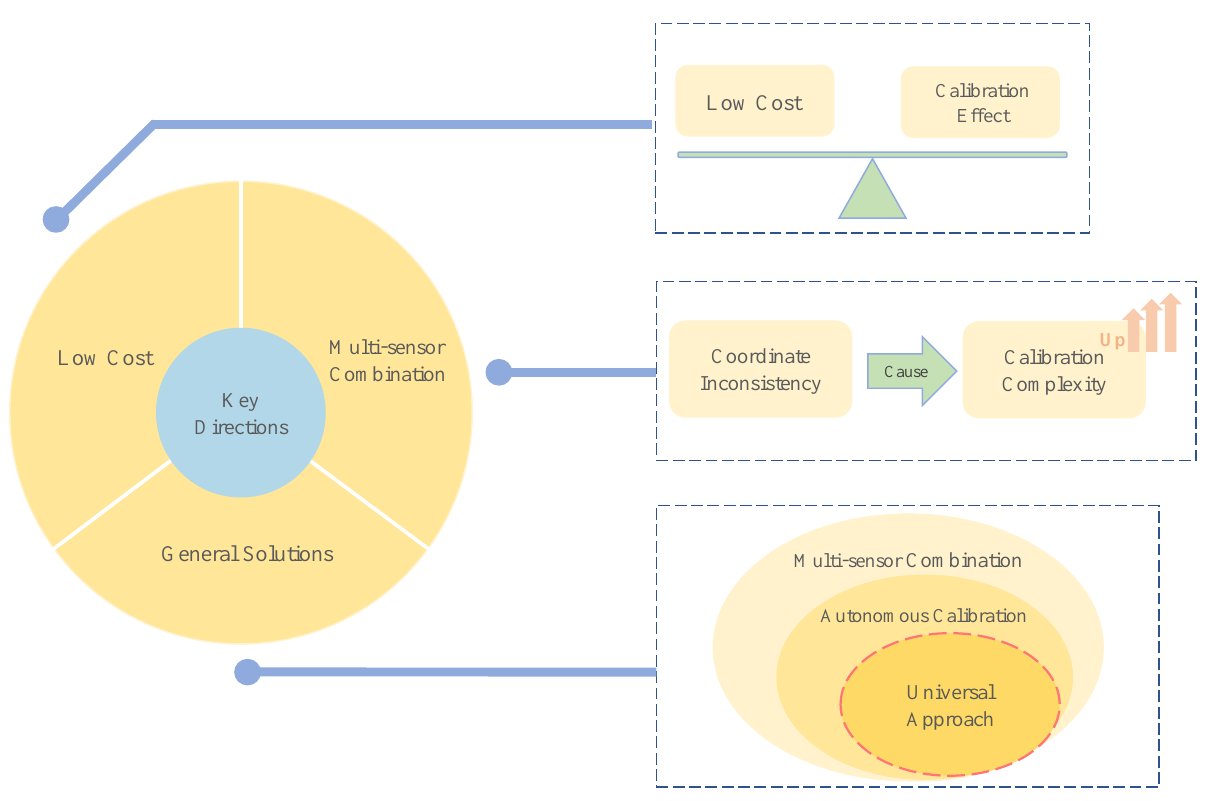
Figure 11. Schematic of key directions. On the right is a further exploration of three key directions, from top to bottom, the balance between low cost and calibration effect, the impact of coordinate inconsistency on multi-sensor combinations, and the lack of a universal solution for autonomous calibration of multi-sensor